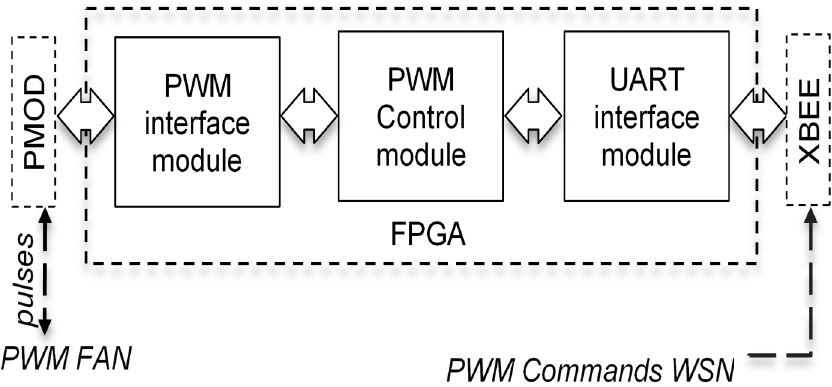
Figure 7. Block diagram of PWM fan control logic.